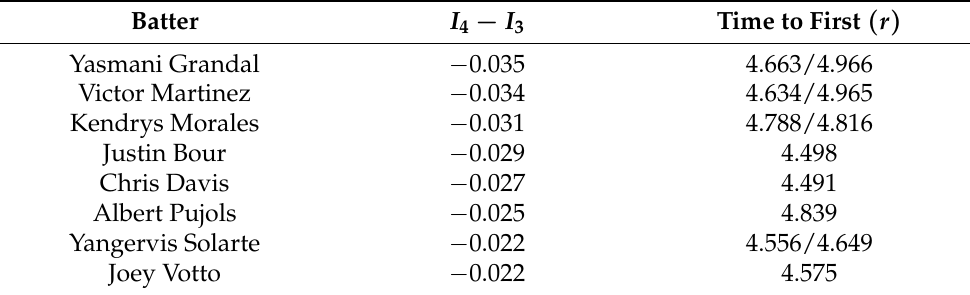
Table 6. Smallest differences between weighted on base average (wOBA) cube and wOBA tesseract values ( I 4 − I 3 ) for 2018 and time to first ( r ) in seconds; two r values are given for switch-hitters. Batter